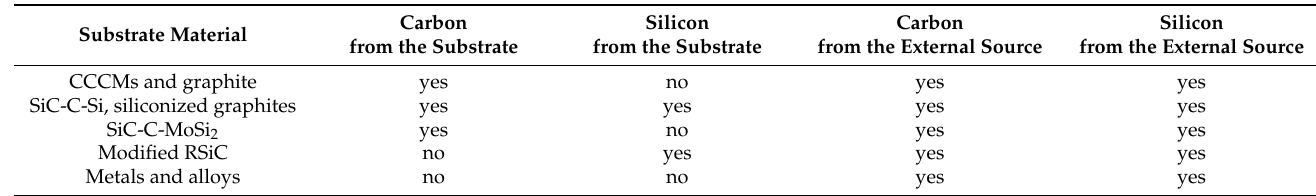
Table 1. Features of SiC coating deposition on various refractory materials.